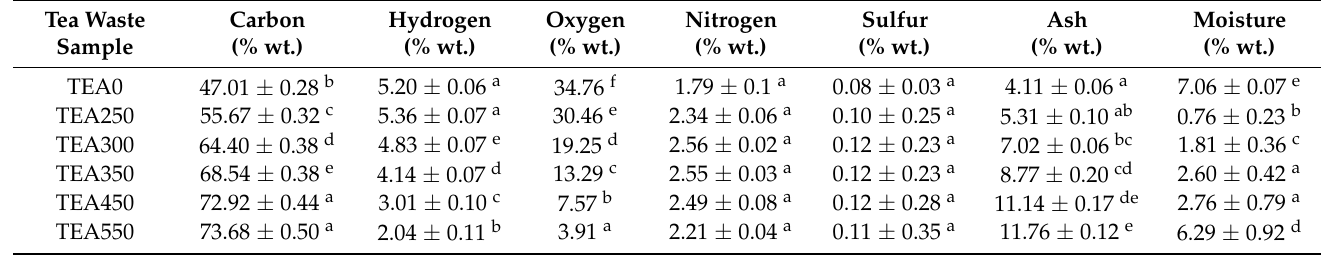
Table 3. Proximate and ultimate analysis for tea waste sample. Values are means ± SE ( n = 3).